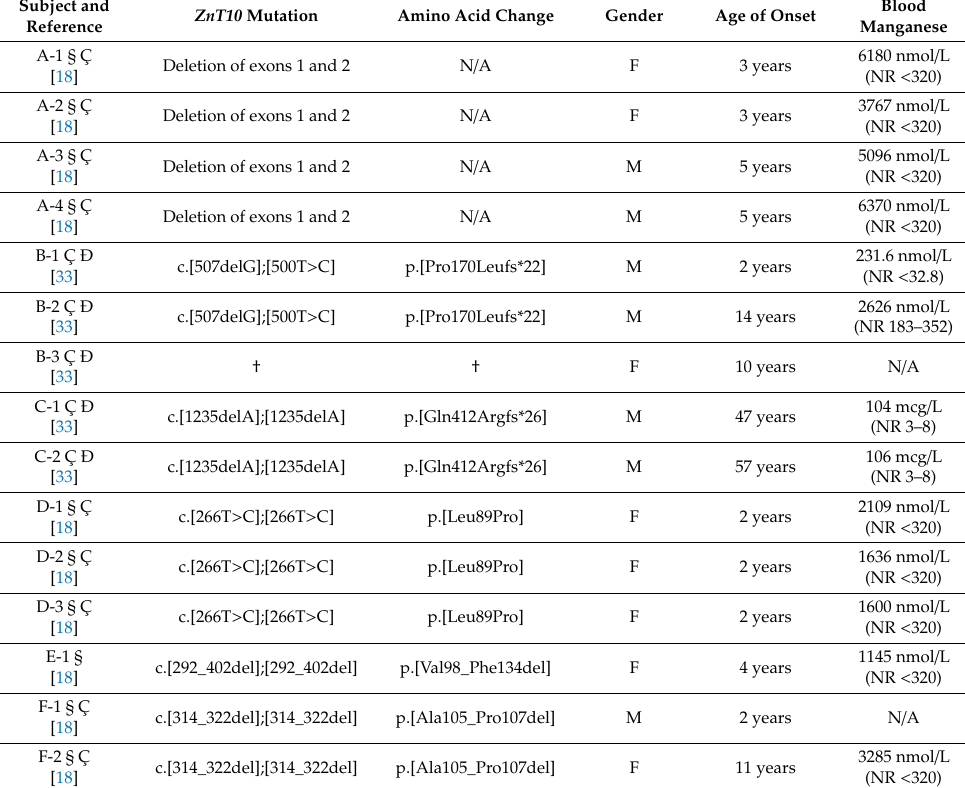
Table 3. Identified human cases of ZnT10